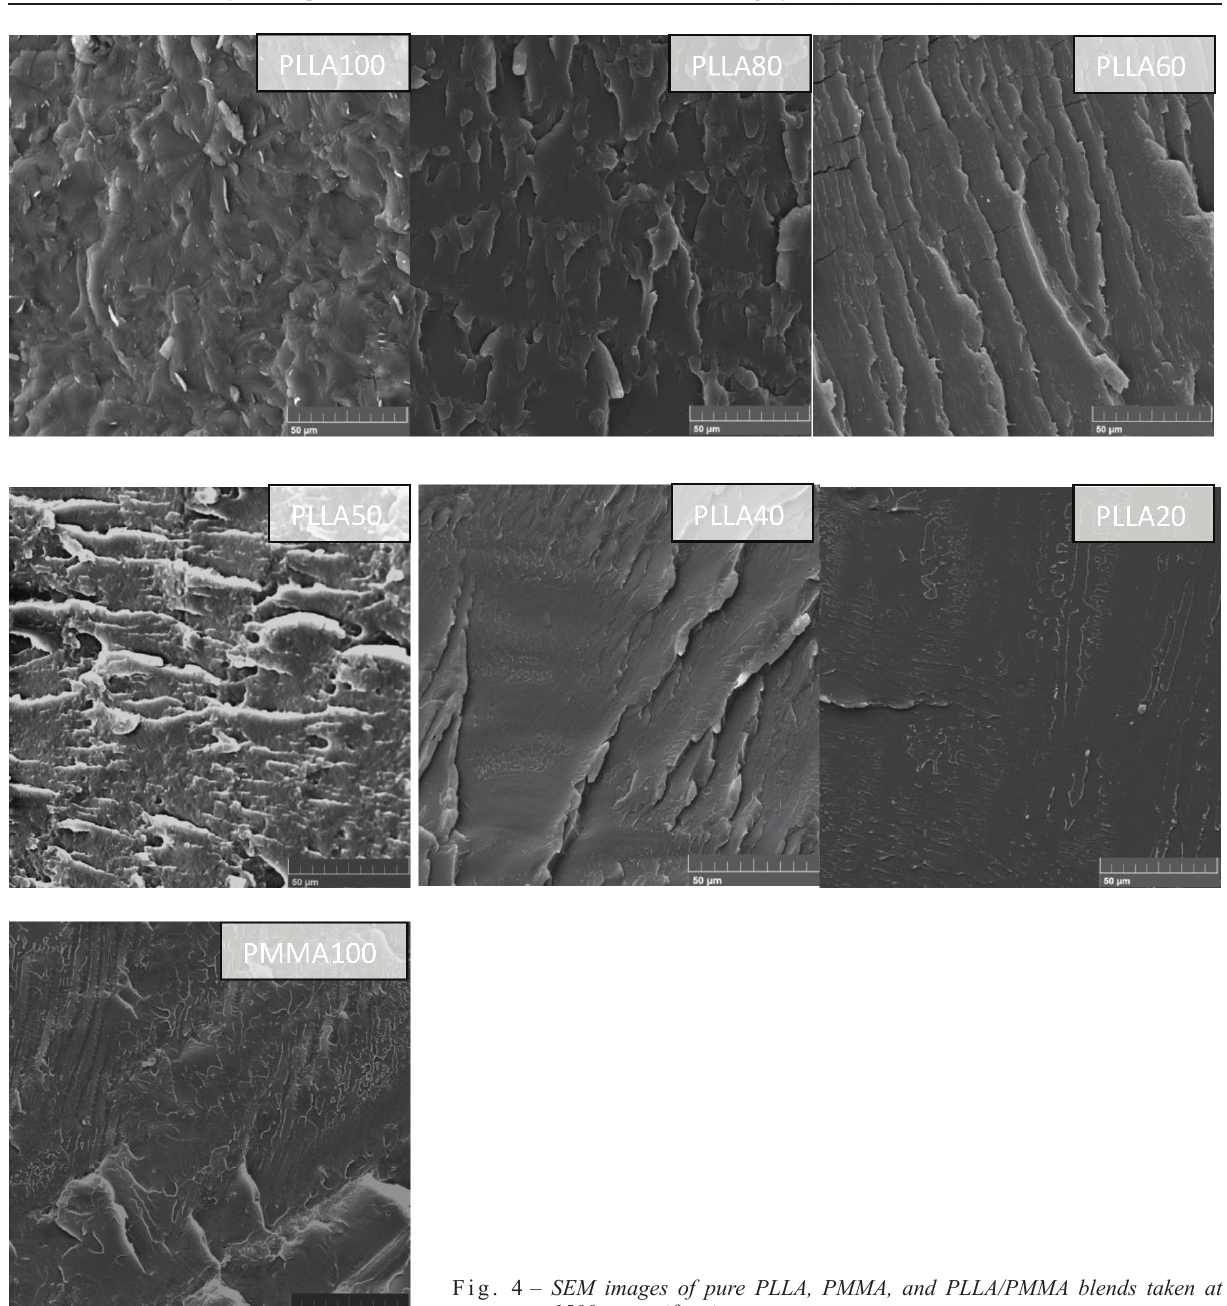
Fig. 4 – SEM images of pure PLLA, PMMA, and PLLA/PMMA blends taken at 1500x